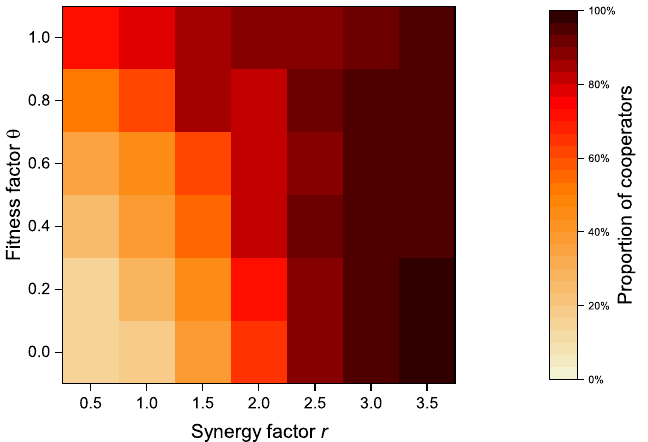
Figure 13. Cooperator proportion of the model for different synergy factors and different fitness factors when the zealots number is 10 and the proportion of altruistic nodes is set to 50%.